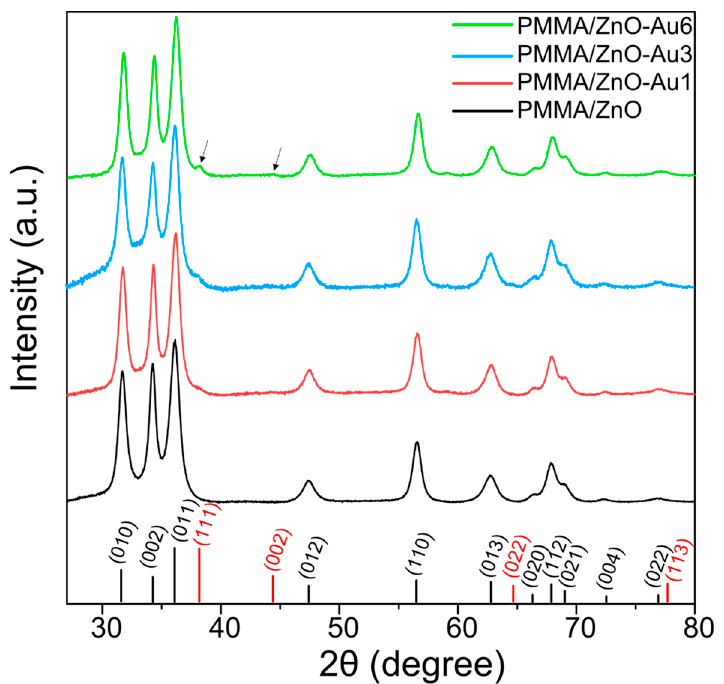
Figure 3. X-ray diffraction (XRD) patterns of the different composite mats. Stick reference pattern of ZnO (black) and of Au (red) are shown along the x-axis. The arrows indicate the detected Au diffraction peaks.